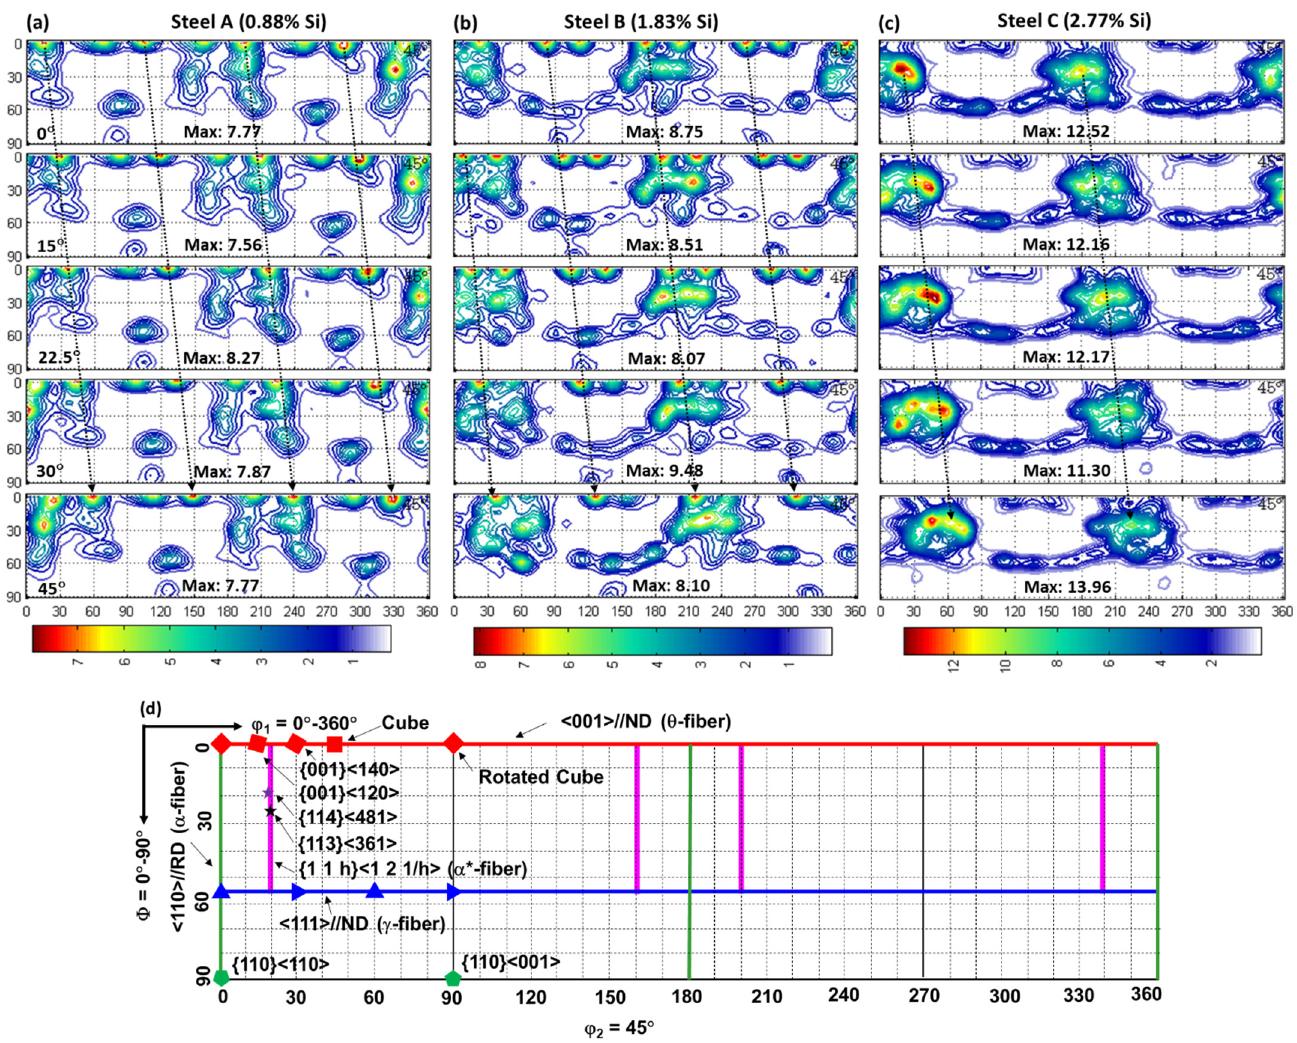
Figure 2. Initial textures before skew cold rolling (rotation of the texture): ( a ) Steel A, ( b ) Steel B, ( c ) Steel C and ( d ) index of the major texture components and fibers. ϕ 2 = 45° ODF sections in Bunge–Euler angles.